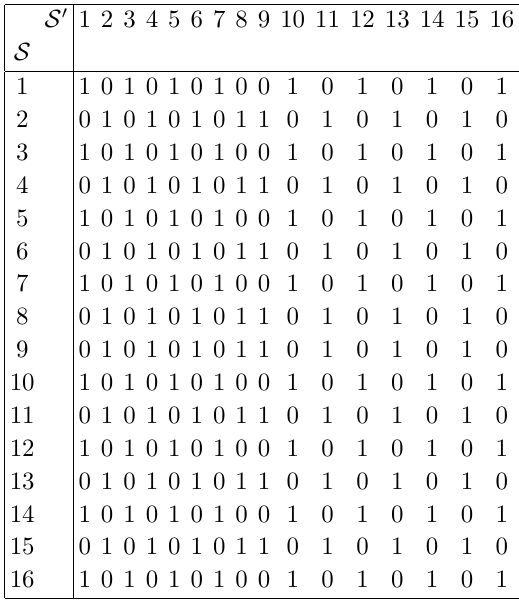
(cid:2) P with di(cid:11)erent boolean [6] [6]